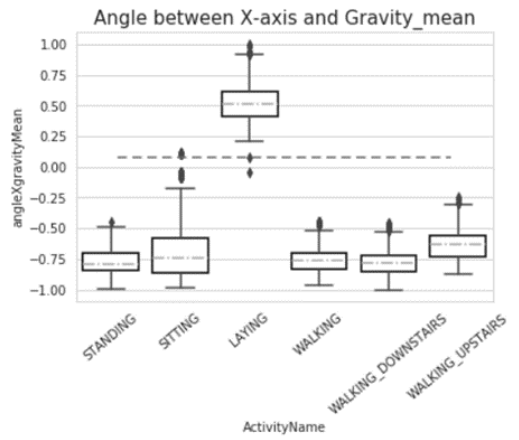
Figure 7. Box-plot of angle between the x -axis and Gravity_mean (before preprocessing).